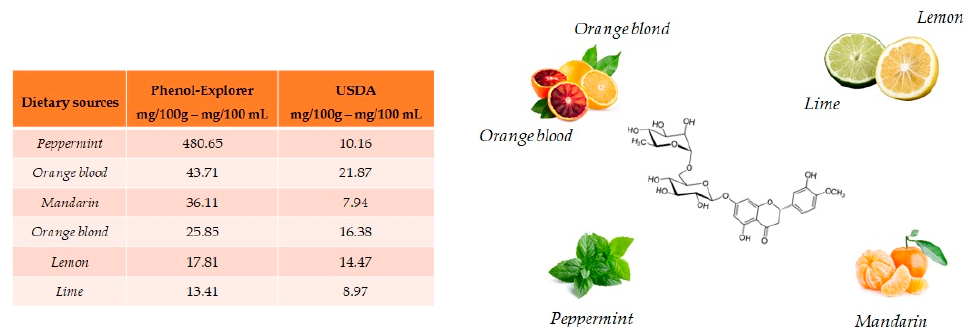
Figure 4. Main foods that contain hesperidin according to the database Phenol-Explore (http://phenol-explorer.eu/ accessed on 29 January 2021) and USDA Database for the flavonoid content of selected foods (https://www.ars.usda.gov/ accessed on 13 February 2021).